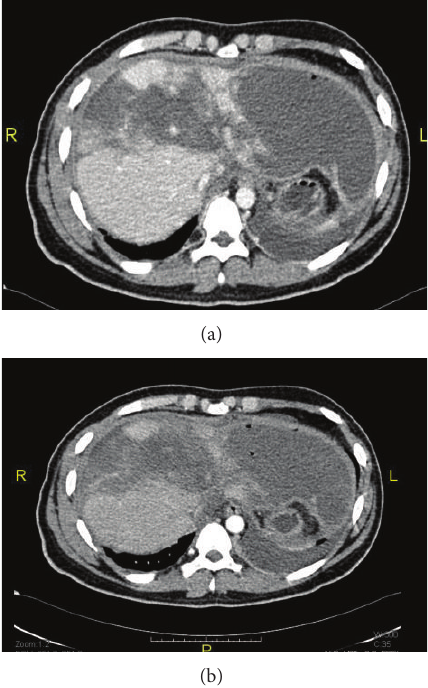
Figure 3: Follow-up abdomen CT (after TAE) showed massive liver necrosis with sparing of the lower part of the right